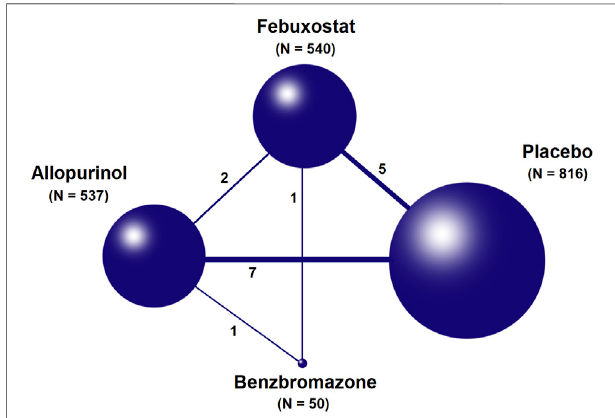
FIGURE2| Networkplotsforrelationsbetweendifferenttherapies.Thewidth oflinesisproportionaltothenumberofstudiescomparingeverypairofinterventions. The size of each circle is proportional to the sample size of each